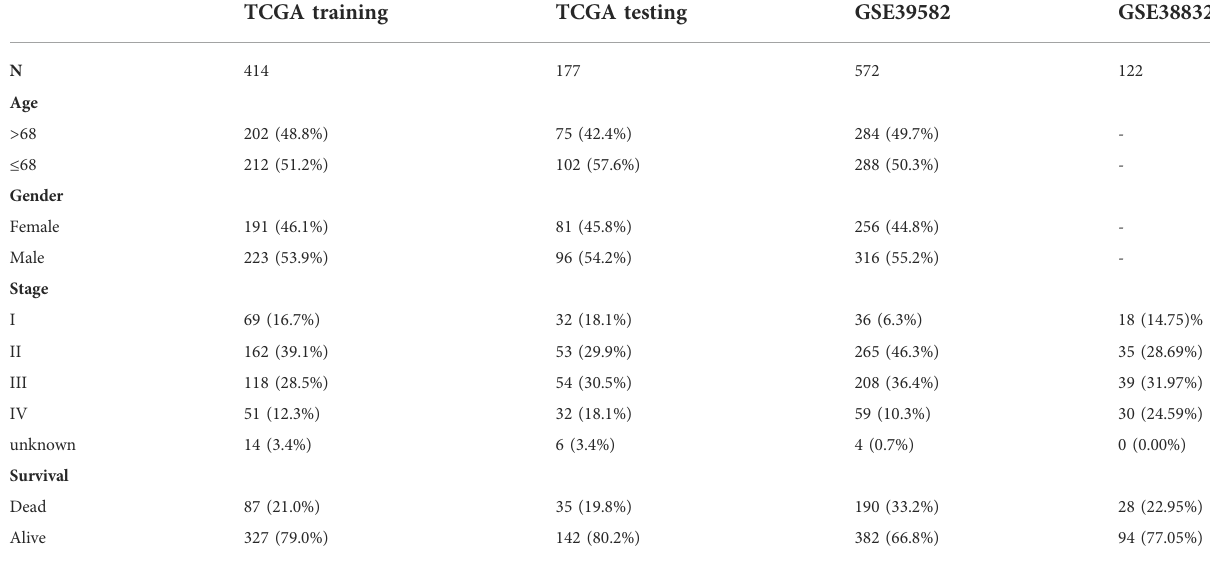
TABLE 1 Summarized clinical characteristics of samples in this